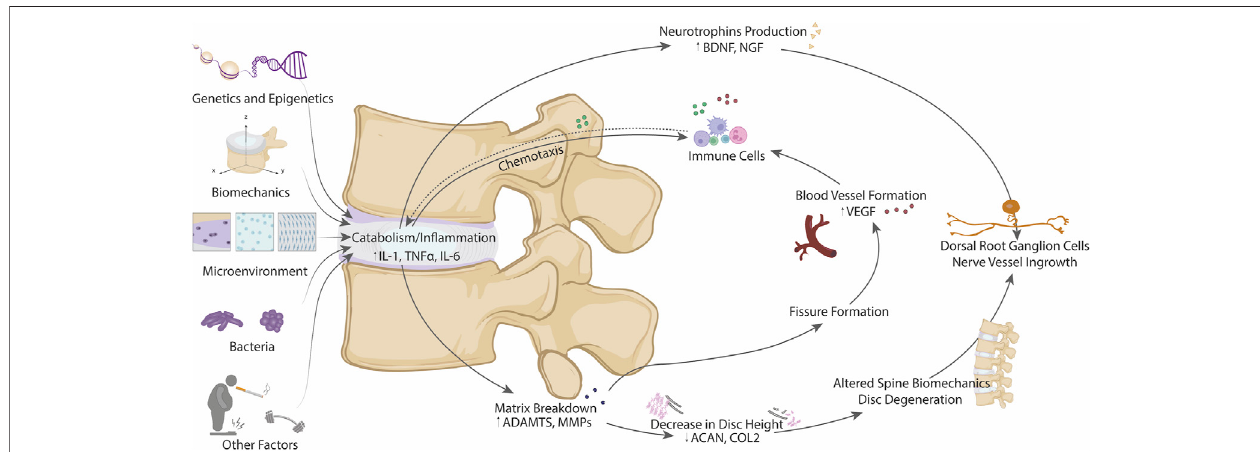
FIGURE 3 | Schematic diagram of the different factors contributing to the metabolic shift from anabolism to catabolism in IDD, including genetics and epigenetics, biomechanics,microenvironment, presence ofbacteria and otherfactors. Allthesecontributorscan promote adownstream biochemical effects (matrix breakdown and neurotrophinsproduction)leadingtostructuralandbiomechanicalalterations,nerveingrowthandbloodvesselformation.Thus,involvementofimmunesystemcouldbe achieved by chemotaxis losing the immuno-privileged state of the IVD.